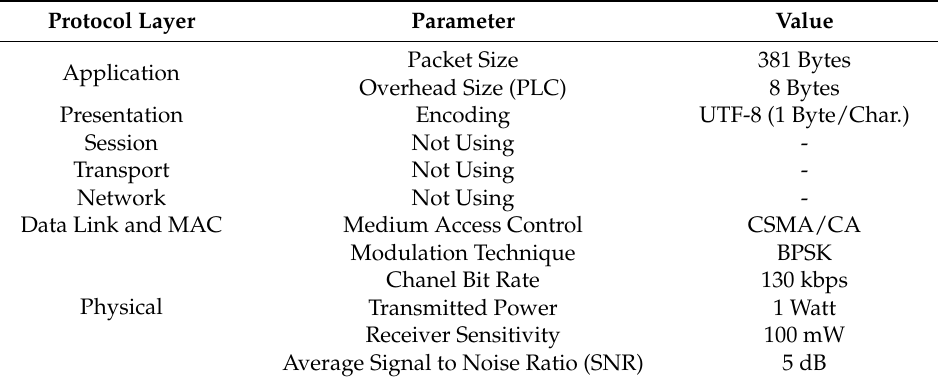
Table 3. The simulation